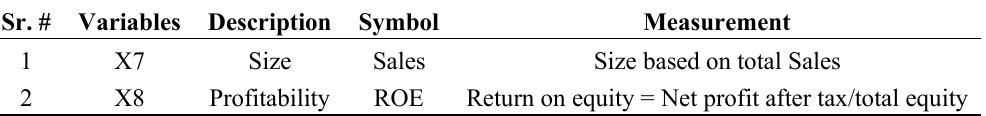
Table 2. Control